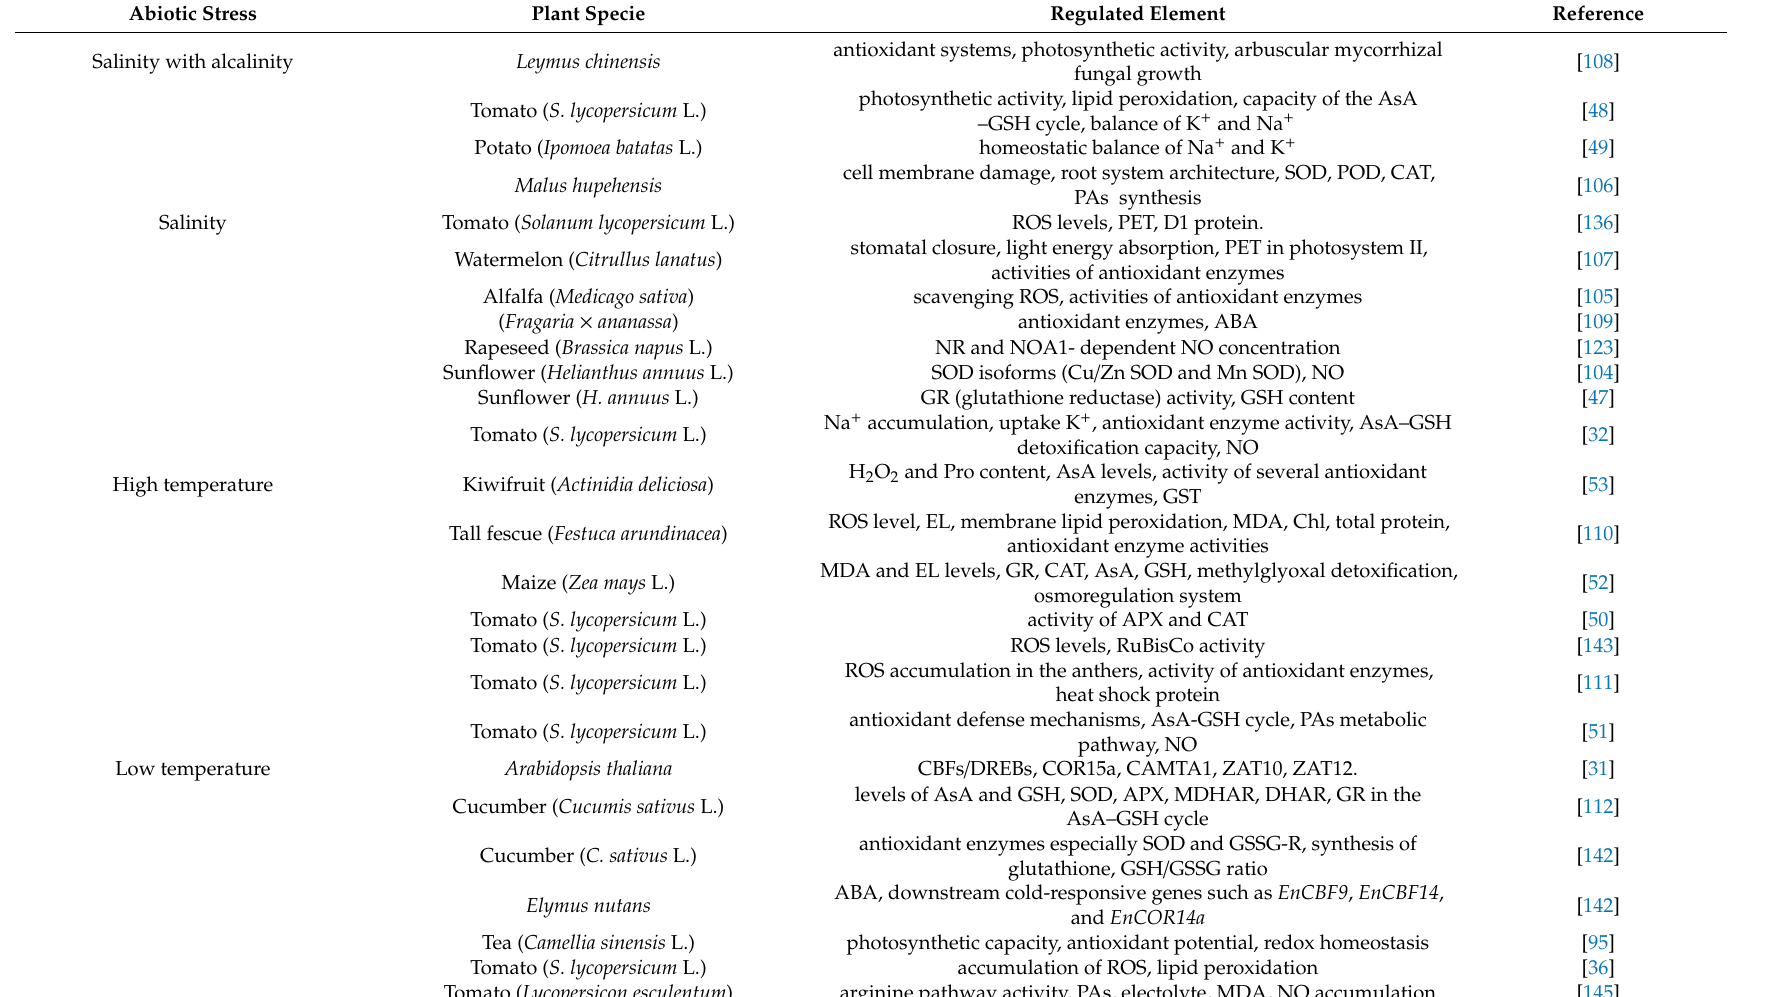
Table 1. Selected studies on the roles played by melatonin in the response of plants to abiotic stresses. Abiotic